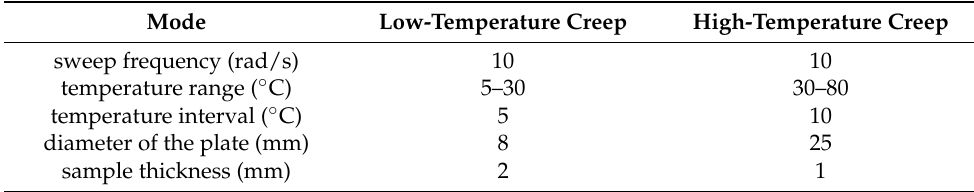
Table 2. Test parameters of the two test modes.